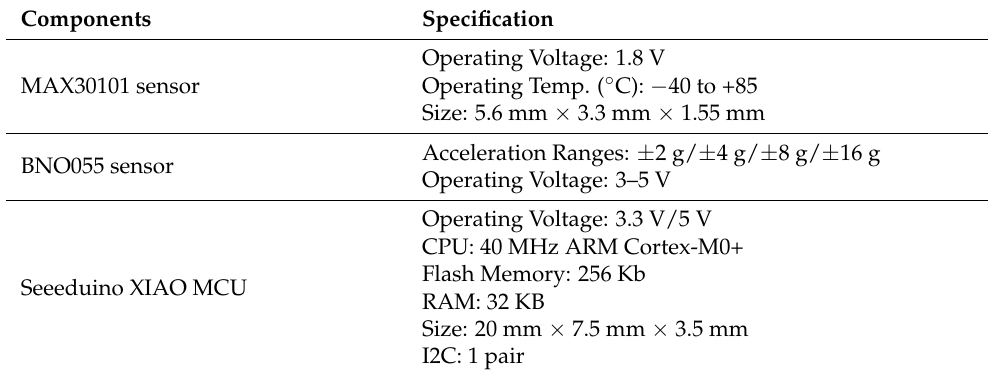
Table 1. Specifications for the components of the